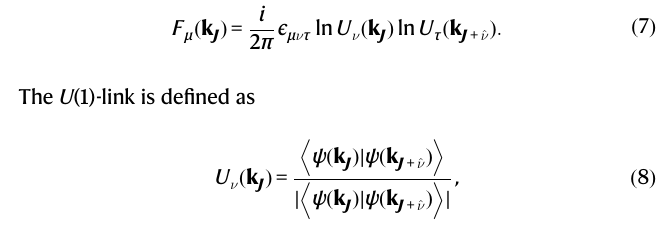
Fig. 4 | The 3D preimage contours which show topological links for the Hopf insulatorwith h=0.5 .a Topologicallink,obtainedfromtwospinstateswithBloch ffiffiffi ffiffiffi p p sphere representations S = ð(cid:3) 1, (cid:3) 1,0 Þ = 2 (blue) and ð 0,1, (cid:3) 1 Þ = 2 (orange), for a legitimate sample in the stereographic coordinates of S 3 , between two spin states on the Bloch sphere. Solid lines are curves from numerically calculated directions S th andthestarsareexperimentallymeasuredspinorientations S exp .Thedeviation − S ∣ ≤ 0.25(0.35) for the blue (orange) curve. b The topological link for an ∣ S exp th adversarial example with deviation ∣ S exp − S th ∣ ≤ 0.25 for blue and orange